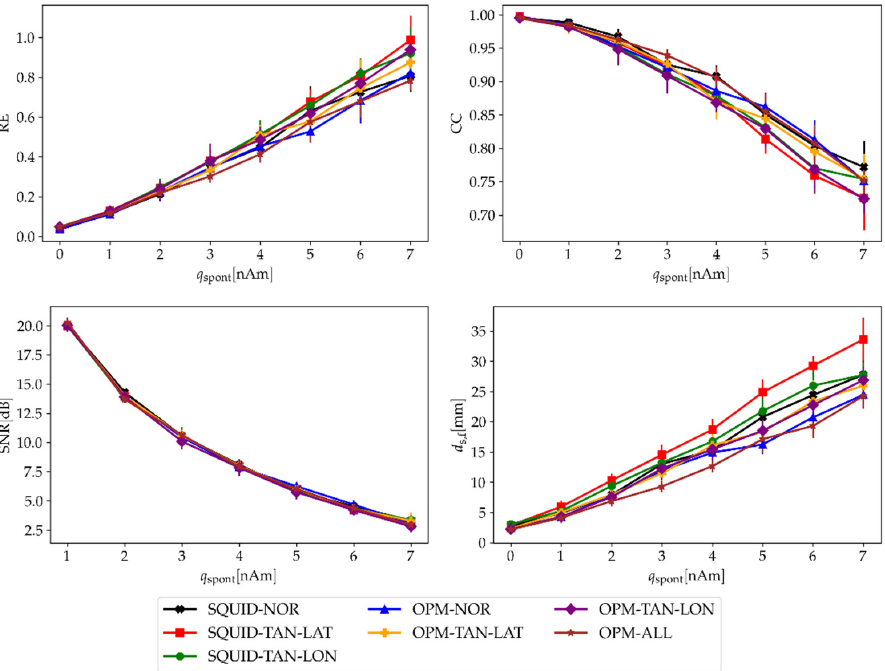
Figure 6. Evaluation parameters (RE, CC, SNR, and d s,f ) averaged over all 100 time samples and eight subjects in relation to the strength of the spontaneous brain noise ( q spont ) for four different OPM-MEG configurations. The strength of the ambient noise was σ = 0. Vertical lines represent the standard deviation between subjects.